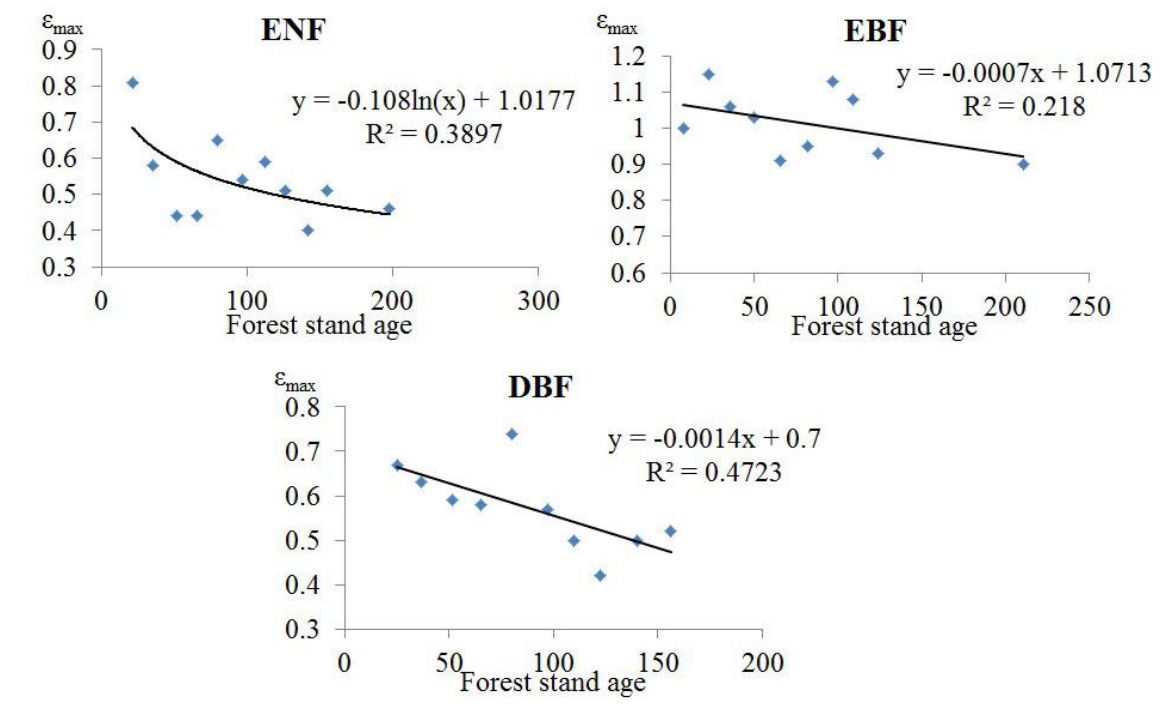
Figure 2 The relationship between the forest stand age and the maximum light-use efficiency (ε max ) of three forest types From Fig.2, The regression equation of the evergreen needleleaf forest is y=-0.108 * ln(x) + 1.0177. The determination of the correlation coefficients (R 2 ) is 0.3897. The ε max has decreased as the forest ages increase, but the relationship between the ε max and the forest stand ages are non-linear. The regression equation of the evergreen broadleaf forest is y=-0.0007 * x + 1.0713. The R 2 is 0.218. The ε max has decreased as the forest stand ages increase, and the relationship is linear. The regression equation of the deciduous broadleaf forest is y=-0.0014 * x + 0.7. The R 2 is 0.4723. The ε max has decreased as the forest ages increase, and the slope is higher than the evergreen broadleaf forest. The